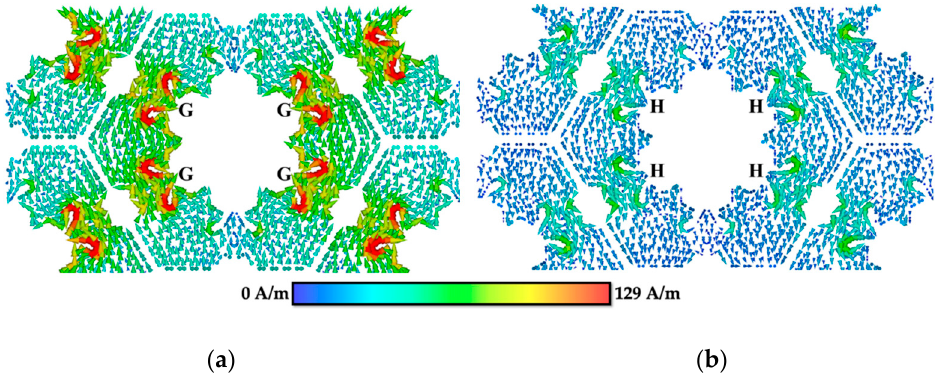
Figure 9. Surface current distribution of FSS 3 at ( a ) 10.43 GHz and ( b ) 37.73